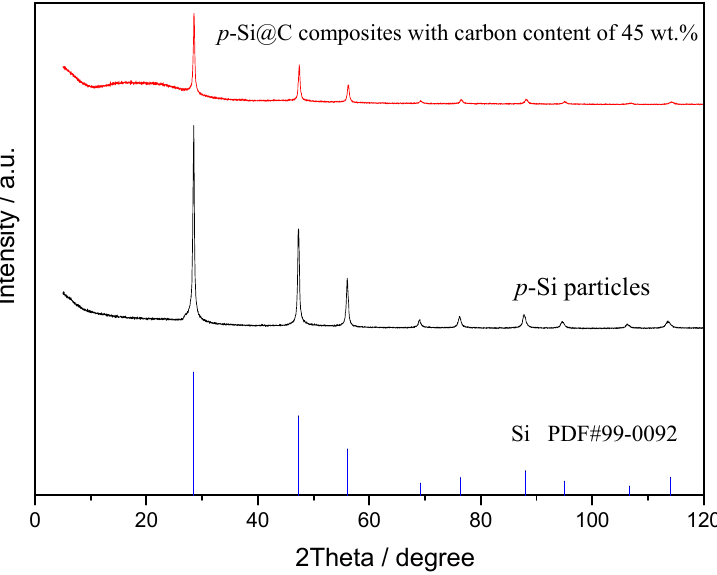
Figure 2. XRD patterns of p -Si particles and p -Si@C composites with carbon content of 45 wt.%.